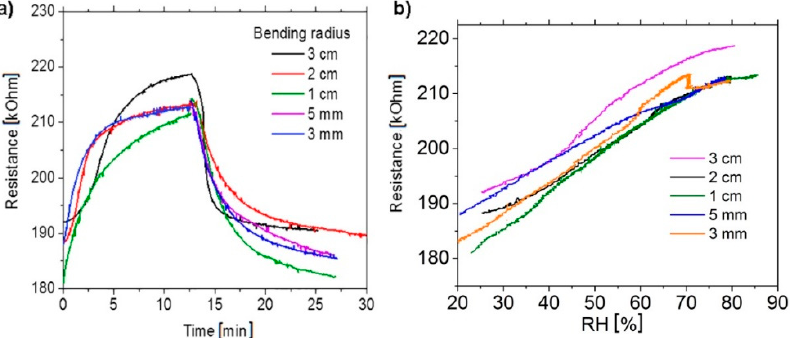
Figure 6. ( a ) Relative change of the resistance of the test structure (see the inset in Figure 6c) printed from G: PEDOT: PSS on a PET substrate as a function of time during the variation of air humidity in the measuring chamber for different tensile deformations of the structure arising from bending. The bending radius is given as a parameter. ( b ) Variation of the resistance of one and the same test structure when sweeping the humidity in two directions versus the bending radius of the structure.